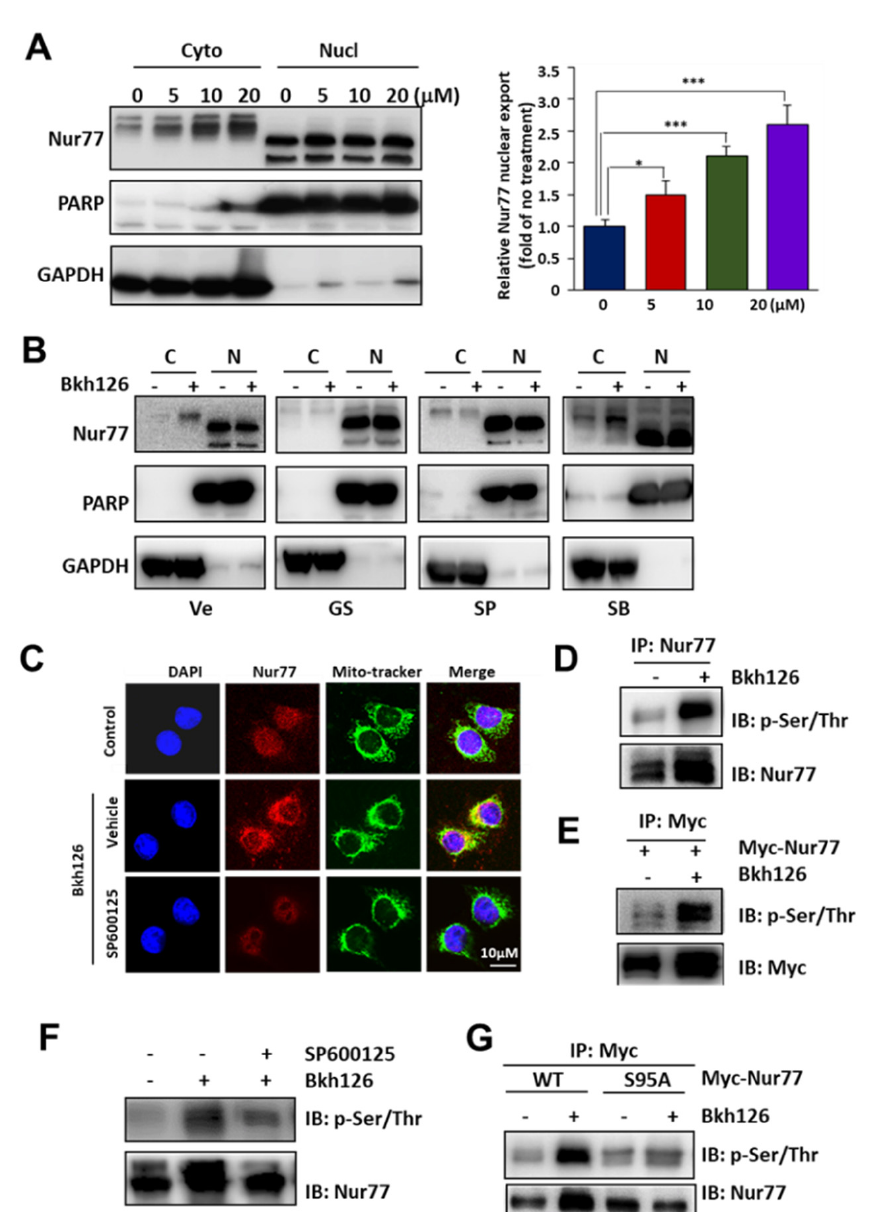
Figure 5. Bkh126 induces Nur77 translocation to mitochondria: ( A , B ) HepG2 cells were treated with Bkh126 (0, 5, 10, and 20 μ M) for 24 h or Bkh126 (20 μ M) in combination with GS ‐ 444217 (ASK1 inhibitor), SP600125 (JNK inhibitor), or SB203580 (p38 inhibitor) for 2 h. The lysates were fractionated in cytosol (C) and nuclei (N). The translocation of Nur77 was analyzed. ( C ) HepG2 cells harboring the green fluorescence of Mito ‐ tracker were treated with 20 μ M Bkh126 for 2 h and then stained with anti ‐ Nur77 and cy3. Fluorescent images were captured using confocal microscopy. ( D , E ) HepG2 cells and HepG2 Nur77 OE stable cells were treated with 20 μ M Bkh126 for 2 h. The cells were lysed and immunoprecipitated with antibody against Nur77 (endogenous) ( D ) or Myc epitope (ectopical) ( E ) and blotted with anti ‐ p ‐ Ser/Thr. ( F ) HepG2 cells were pre ‐ treated with SP600125 (JNK inhibitor) for 1 h and then 20 μ M Bkh126 for 2 h. The phosphorylation of Nur77 was determined with anti ‐ p ‐ Ser/Thr in Nur77 ‐ immunoprecipitated complex. ( G ) HepG2 cells were transfected with wildtype Nur77 or Nur77 S95A and treated with 20 μ M Bkh126 for 2 h. The lysates were immunoprecipitated with anti-Nur77 or anti-Myc and subjected to anti-p-Ser/Thr staining. * p < 0.05, and *** p <